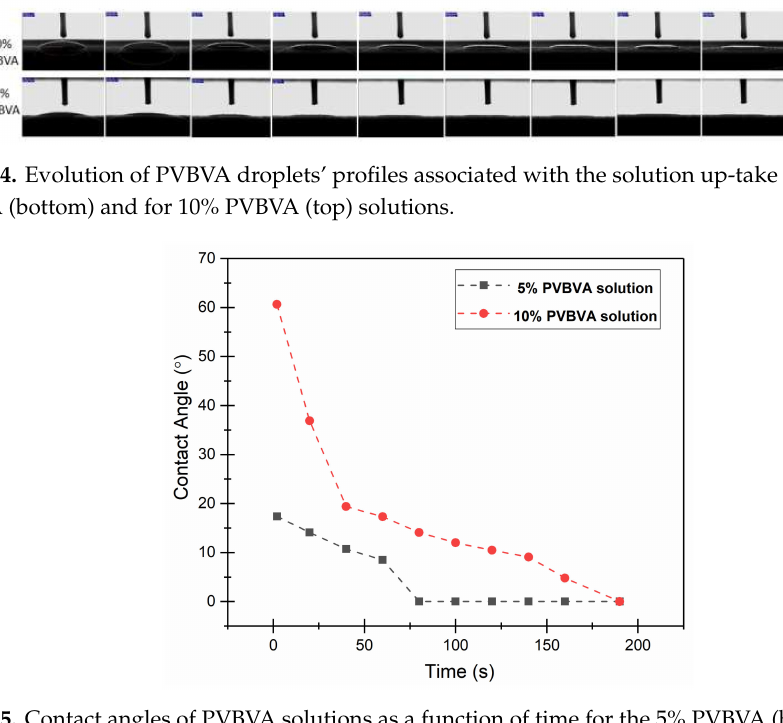
Figure 5. Contact angles of PVBVA solutions as a function of time for the 5% PVBVA (black) and 10% PVBVA (red)